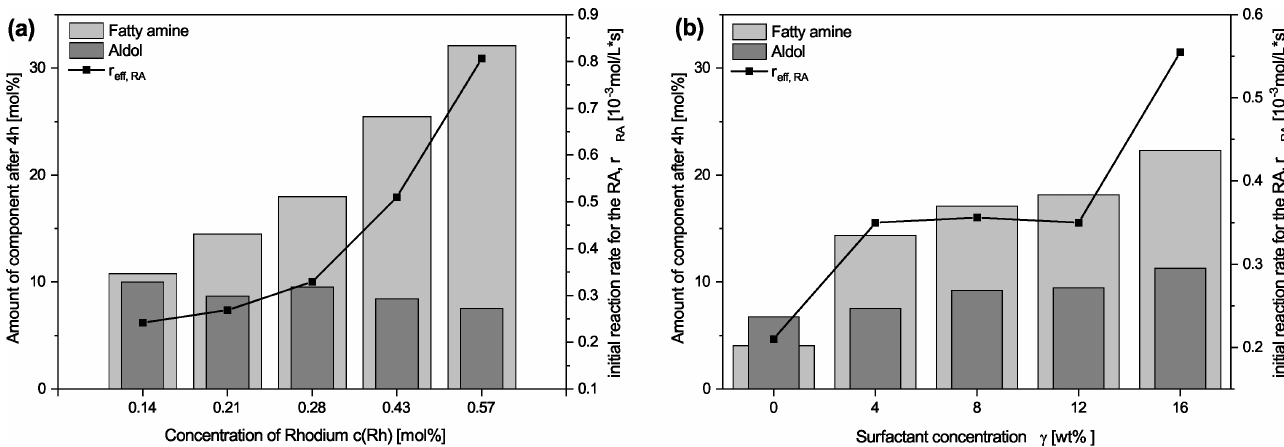
Figure 5. Effect of catalyst concentration ( a ) and the surfactant concentration ( b ) on the reductive amination and their effective reaction rates. Reaction conditions: p=30bar, T=100 °C, Rh:SX=1:4, 17.6 mmol undecanal, 9g dodecane (co- solvent), 12g water, α =0.5, 1wt% Na 2 SO 4 , 1200rpm, t =4h. ( a ) γ =0.08 Marlophen NP8, ( b ) 0.28mol%